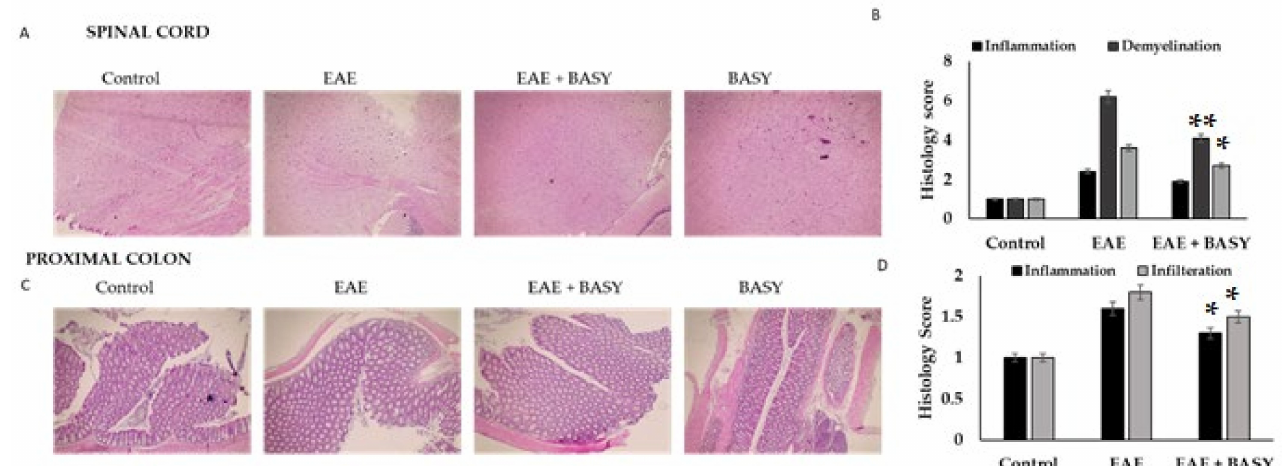
Figure 2. BASY ameliorated the histopathological hallmarks in the CNS and colon of EAE mice. On the 24th day of MOG post-immunization, spinal cords were euthanized from EAE mice, fixed in 10% formaldehyde following paraffin embedding and sectioned into 4 µ m thick sections. ( A ) De- myelination was assessed in the spinal cords using H&E, and the pathological scores were recorded at 200 × magnification power. ( B ) Infiltration and inflammation scores were noted. ( C ) Intestinal integrity and mucin damage were assessed using H&E of the proximal colon of EAE mice. ( D ) In- filtration of T-lymphoid cells, neutrophils, and inflammation scores were noted on the 24th day of MOG post immunization. Data were pooled from three independent experiments and shown as mean ± SD. * p < 0.05. ** p <